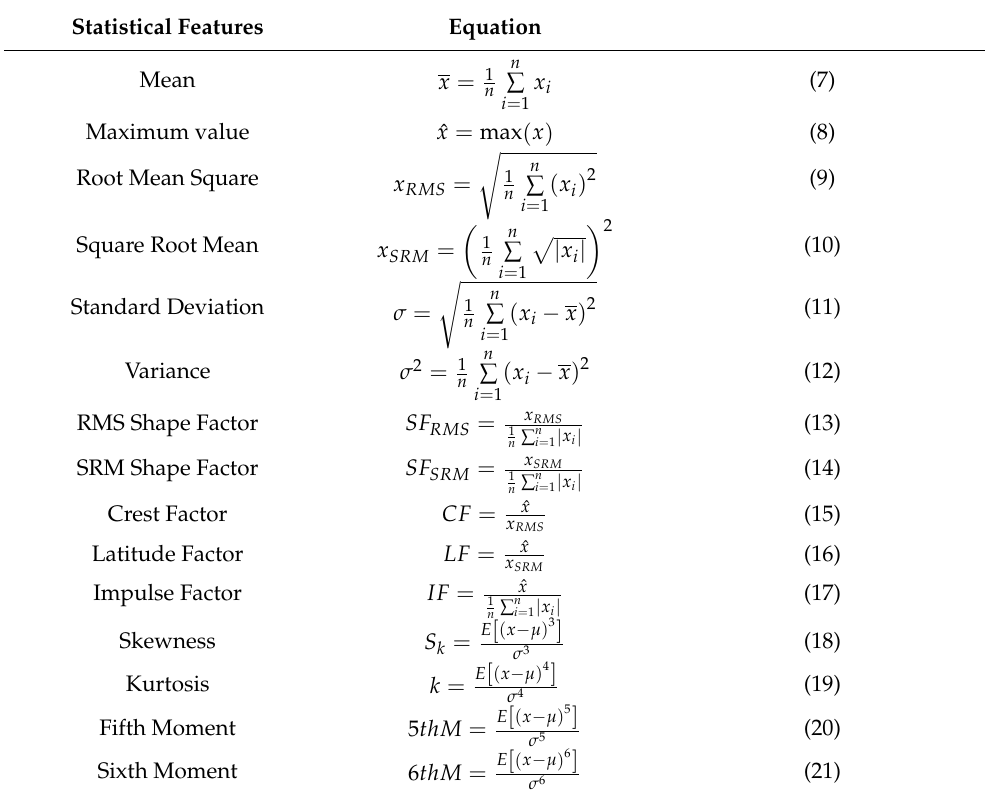
Table 1. Set of statistical features used for the analysis of the